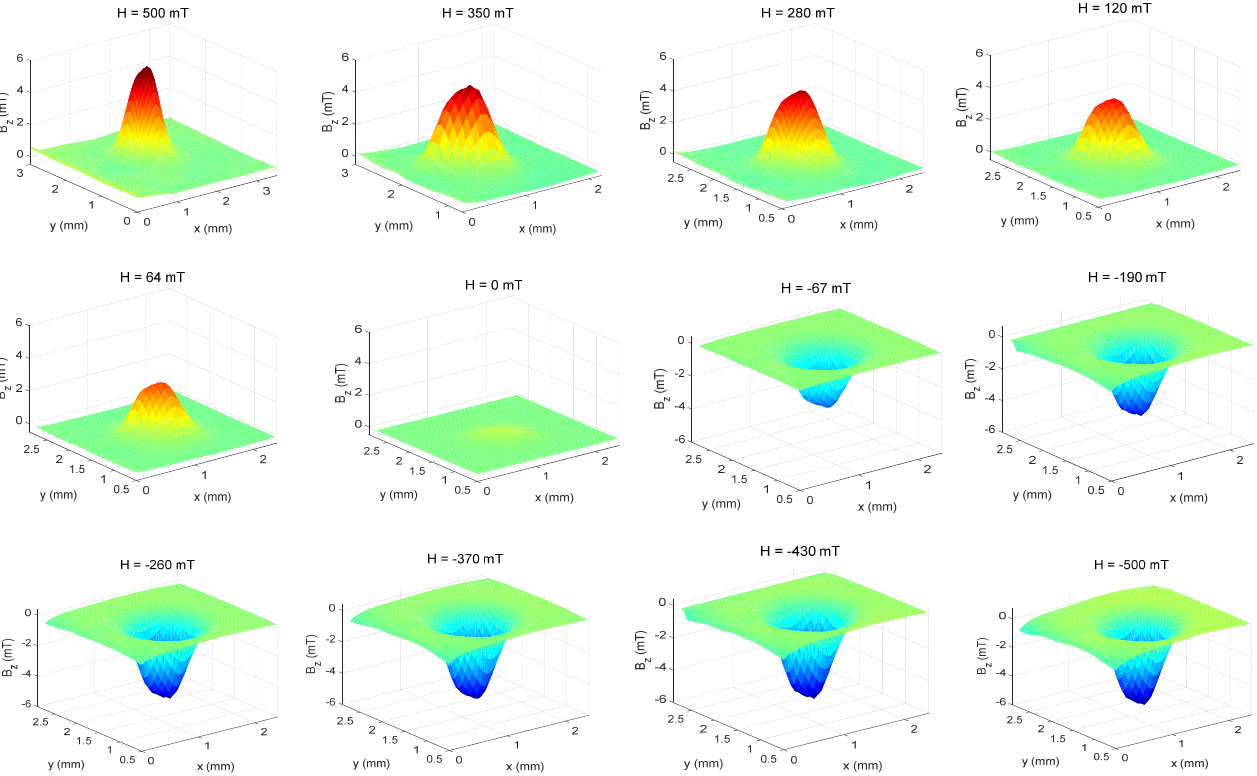
Figure 14. Magnetic maps of the sample NP2 in 3D, obtained directly from the maps in XY space.